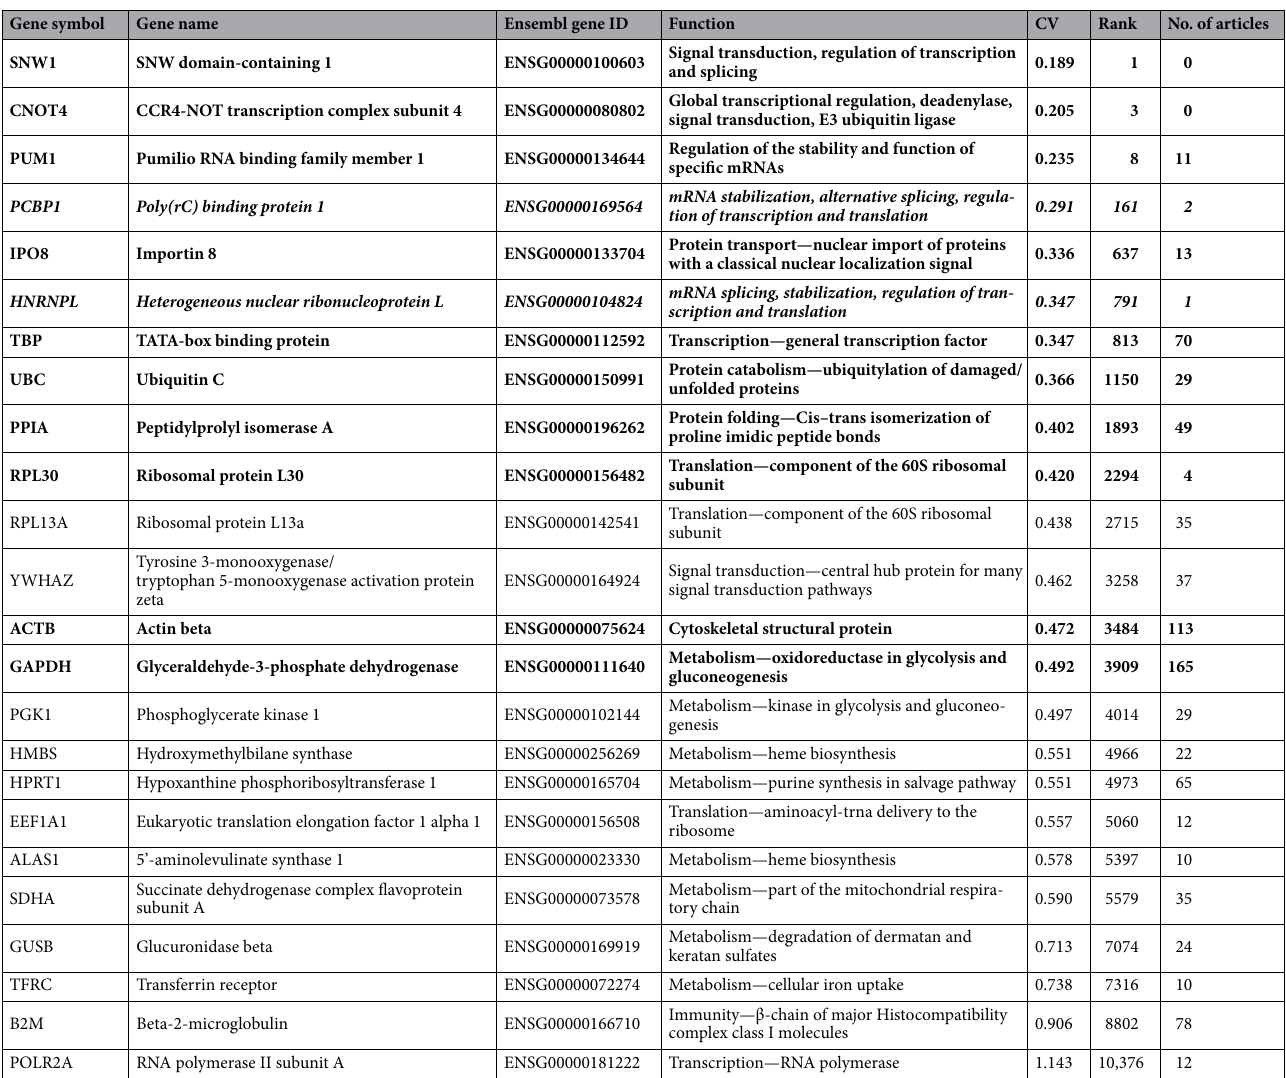
Table 2. List of potential reference genes. Coefficient of variation (CV) and the corresponding rank is calculated from the relative expression data in the RNA HPA cell line gene dataset from The Human Protein Atlas 39,40 . Genes are arranged in ascending order of the rank. The genes used in the present study are shown in bold. Genes suggested by Jo et al. are shown in ita l ic 34 . For details regarding the No. of articles, refer to